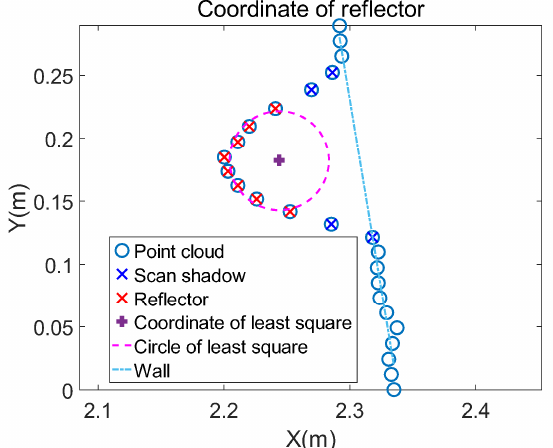
Figure 10. After removing scan shadows, the remaining point clouds belongs to the wall except reflector point clouds. The two boundaries determine the wall range. The line of the wall cross section can be fitted according to point clouds within the range.